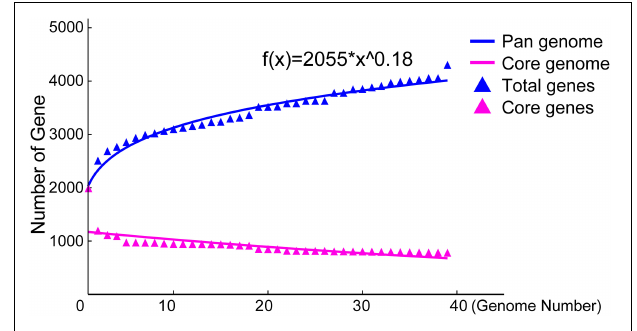
FIGURE 7 | Pan- and core-genome plots of W. confusa based on the results of pan-genome analysis of 39 W. confusa strains.